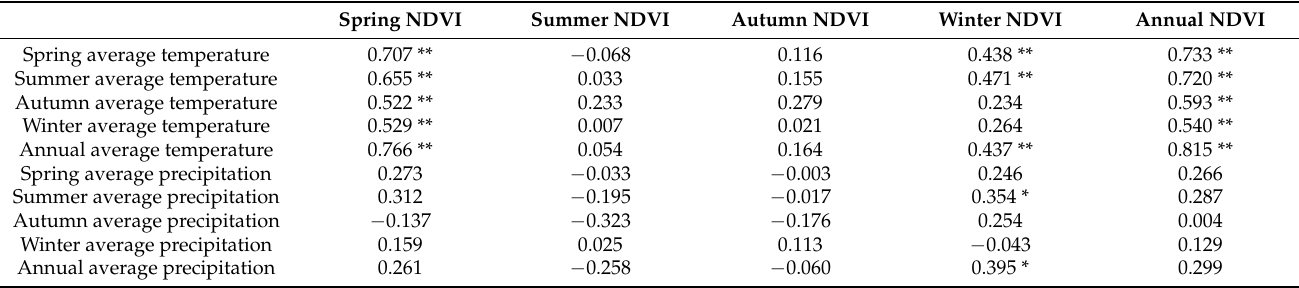
Figure 12. Seasonal correlation analyses ( α = 0.05) between vegetation and precipitation. Table 4. CC of NDVI with temperature and